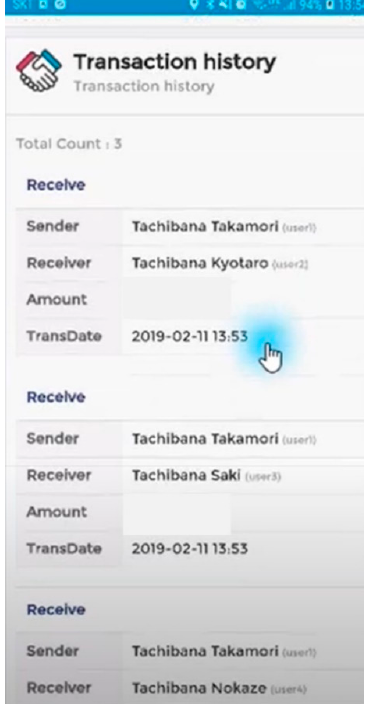
Figure 18. Legacy inheritances smart contract hash storage screen.